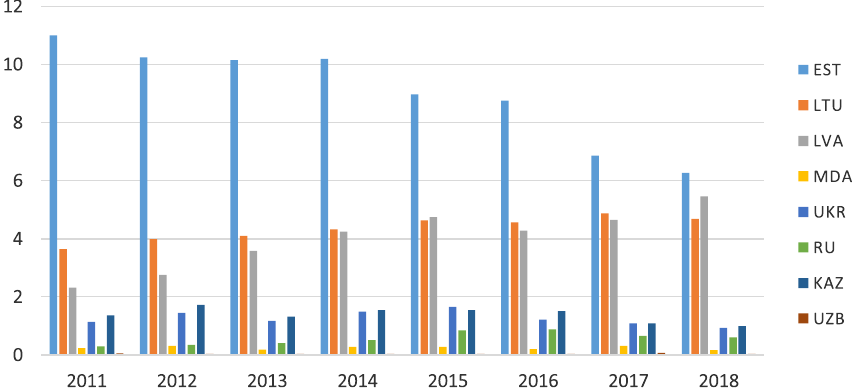
Figure 8. High-technology exports (% of GDP) in post-Soviet